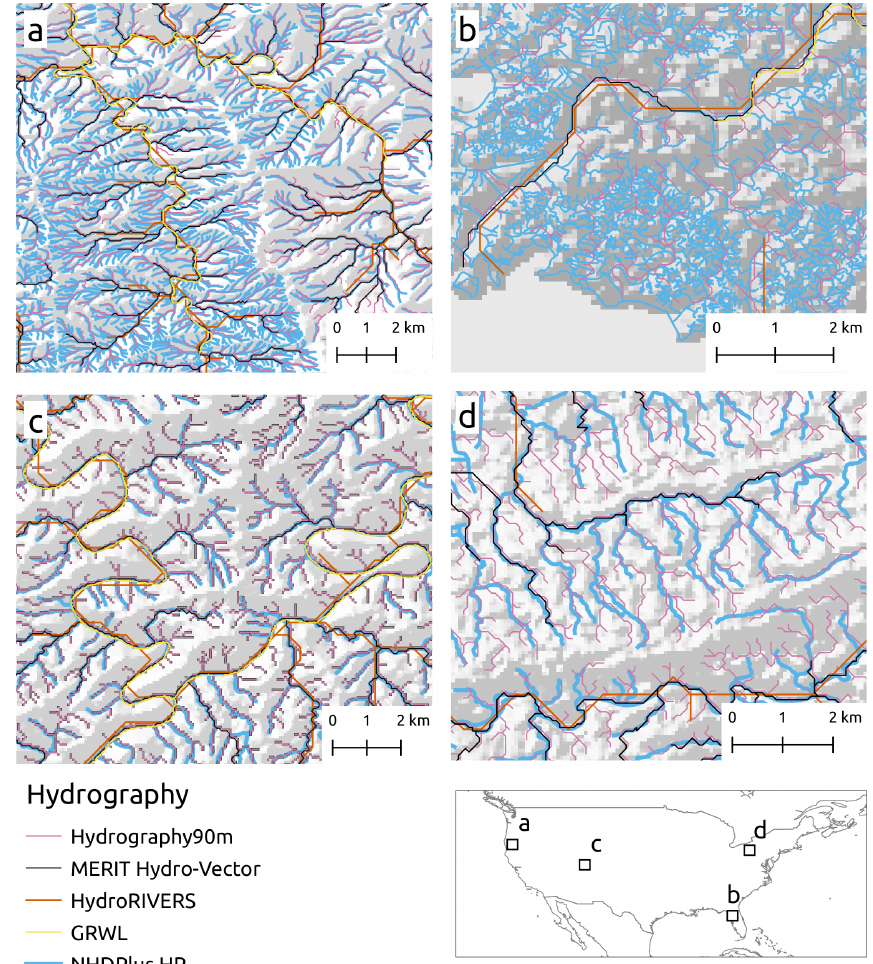
Figure 9. Visualisation of the different global hydrographic datasets (Hydrography90m, MERIT Hydro-Vector, HydroRIVERS, GRWL) against the high-resolution NHDPlus HR reference dataset of the United States (Buto and Anderson, 2020). The geographic location of the four panels (a) – (d) corresponds to the labels in the